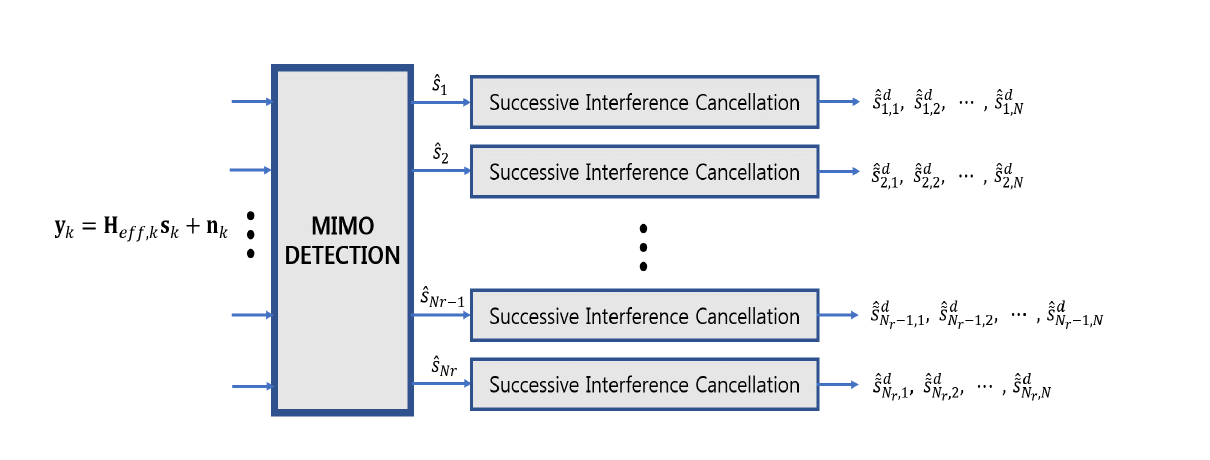
Figure 6. The proposed signal detection